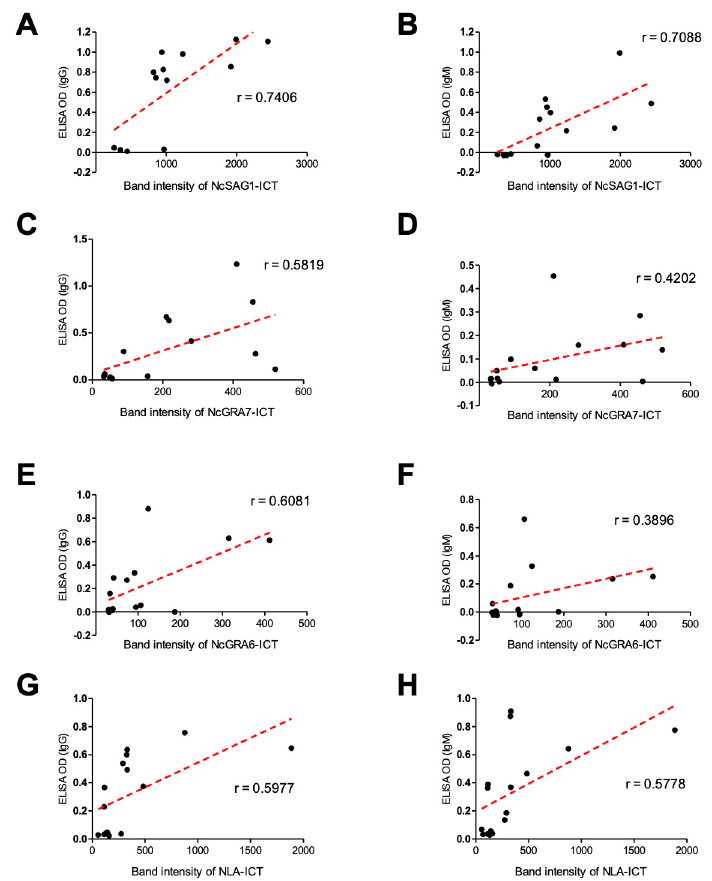
Figure 6. Correlation between immunochromatographic test (ICT) band intensity and enzyme-linked immunosorbent assay (ELISA) OD values of experimental cattle sera. Scatter graphs show the correlation between relative band intensity in the ICT and absorbance values in the ELISA using serum samples from non-infected ( n = 6) and N. caninum -experimentally infected cattle sera ( n = 9). The equation represents the approximation formula. The break line represents the calculated line of best fit. Correlation coefficients were calculated using Pearson’s correlation coefficient: |r| = 0.70, strong correlation; 0.5 < |r| < 0.7, moderately strong correlation; and |r| = 0.3–0.5 weak-to-moderate correlation. NcSAG1, correlation coefficient (r): r = 0.7406 for IgG-ELISA ( A ), and r = 0.7088 for IgM-ELISA ( B ). NcGRA7, r = 0.5819 for IgG-ELISA ( C ), and r = 0.4202 for IgM-ELISA ( D ). NcGRA6, r = 0.6081 for IgG-ELISA ( E ), and r = 0.3896 for IgM-ELISA ( F ). NLA, r = 0.5977 for IgG-ELISA ( G ), and r = 0.5778 for IgM-ELISA ( H ).